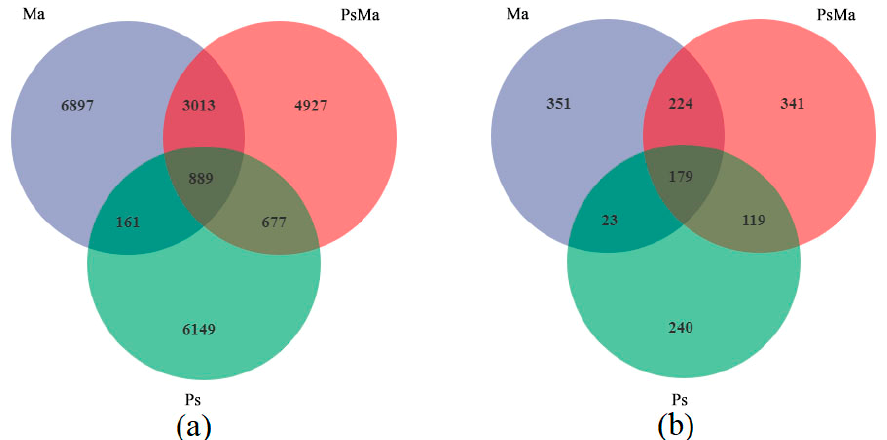
Figure 2. Venn diagram showing unique and shared OTUs of leaf litter microbial for three different samples. ( a ): Unique and shared OTUs of leaf litter bacteria in three different samples; ( b ): Unique and shared OTUs of leaf litter fungal in three different samples. Ma: Morus alba ; PsMa: Pinus sylvestris var. mongolica × Morus alba ; Ps: Pinus sylvestris var. mongolica . Alpha diversity index analysis was performed on samples with different leaf litter ratios, and boxplots were drawn. The litter bacterial diversity indices, including the Chao1 index ( p = 0.015), Pielou_e index ( p = 0.0073), Goods_coverage ( p = 0.015), Shannon index ( p = 0.012), Simpson index ( p = 0.018) and Observed_species ( p = 0.018), showed